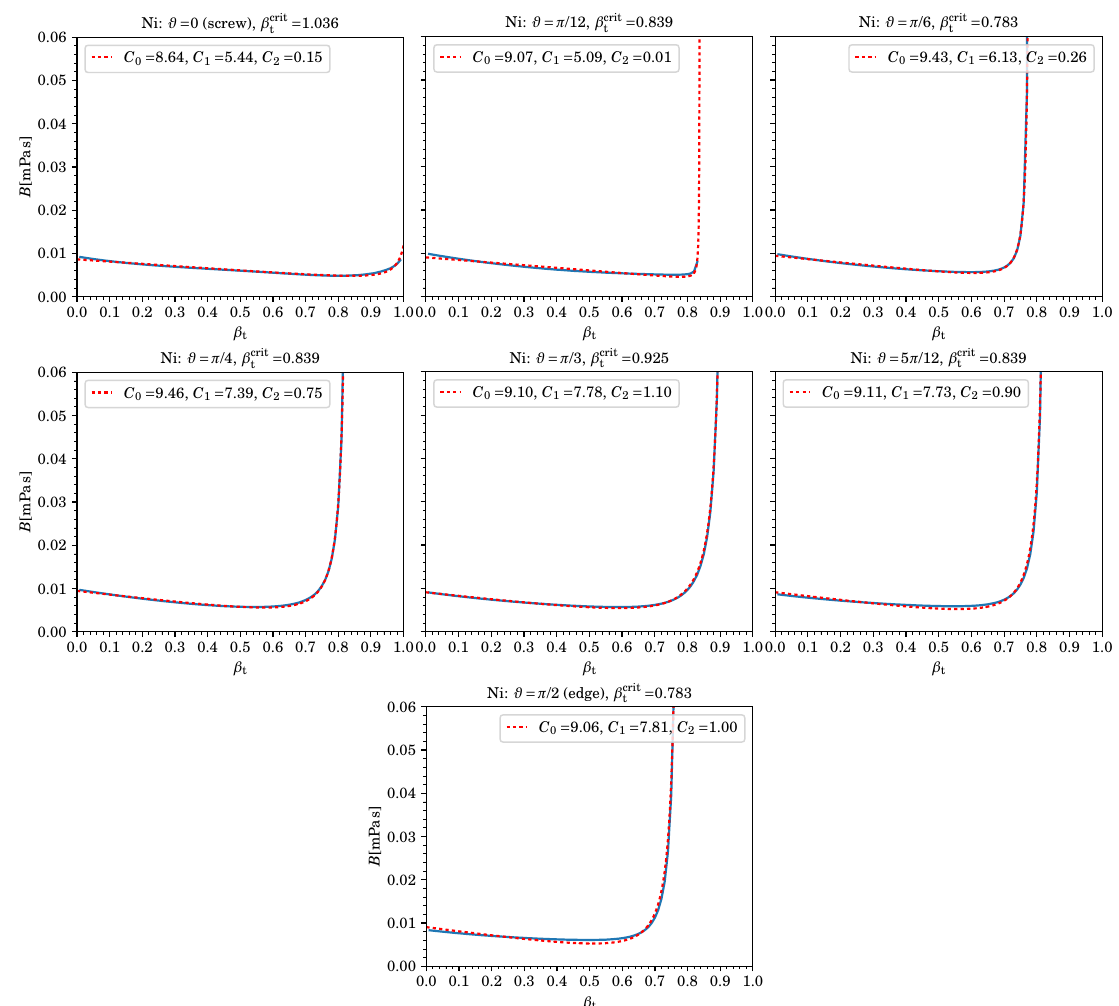
Figure 1. We show the drag coefficient B ( β T ) from phonon wind for dislocations in Ni of various character angles ϑ . The dashed lines represent the three-parameter fitting functions with fitting parameters C i in units of µ Pas, critical velocity β crit the results of numerically evaluating B according to Equation (1) using the software in Ref. [24], see Ref. [13] for details on the